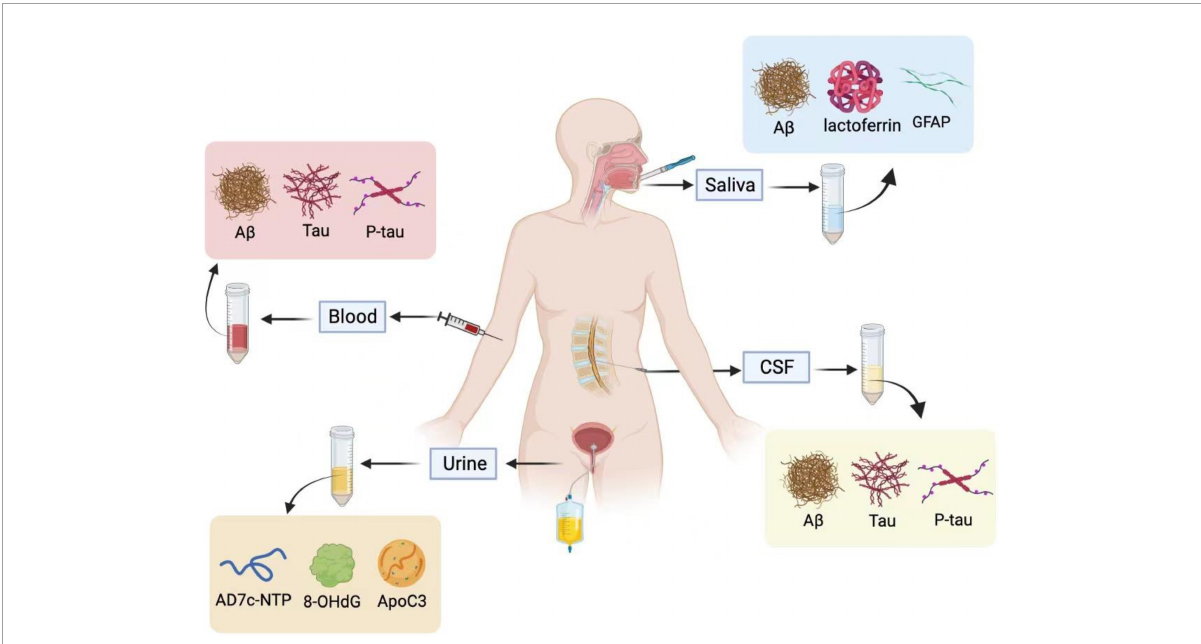
FIGURE1 Saliva, blood, cerebrospinal fluid (CSF), and urine are used for Alzheimer’s fluid biopsy. In the CSF and blood, A β , T-tau, and P-tau are used as biochemical indicators for the early diagnosis of Alzheimer’s disease. The specific biomarkers in the urine are AD7c-NTP, 8-OHdG, and ApoC3, and salivary biomarkers are A β , Lactoferrin, and GFAP. Illustrations were generated using